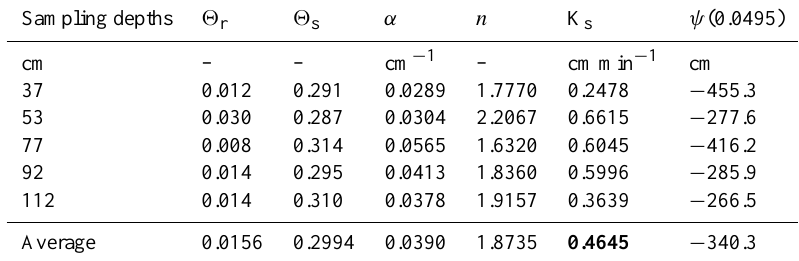
Table 2. Van Genuchten hydrodynamic parameter measurements for five undisturbed soil samples. Measurements were performed using Wind methods with parameter adjustment by inversion using the Hydrus (1.4) software. The resulting potential head ( ψ ) for a water content of 0.0495. (in bold: geometric mean).